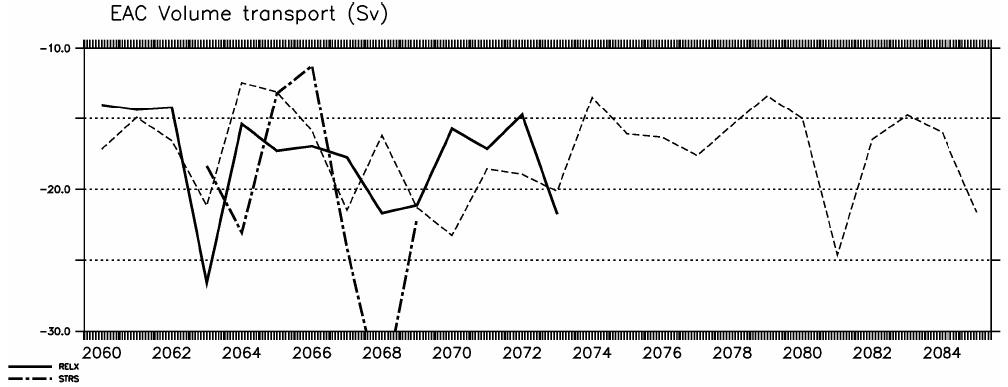
Fig. 7. EAC volume transport (1Sv = 10 6 m 3 s − 1 ) in ODM experiments through a section at 28 ◦ S. Volume transports shown are annual averages of the integrated north–south flow through 153–157 ◦ E and 0–600m depth; values are negative since the flow is to the south. Transport in CTRL is a thin dashed line, which is shifted in time, RELX is a solid line, STRS is a dash–dot line. Note that all these experiments use repeat-year forcing, so the year values only indicate the year into each simulation, not the calendar